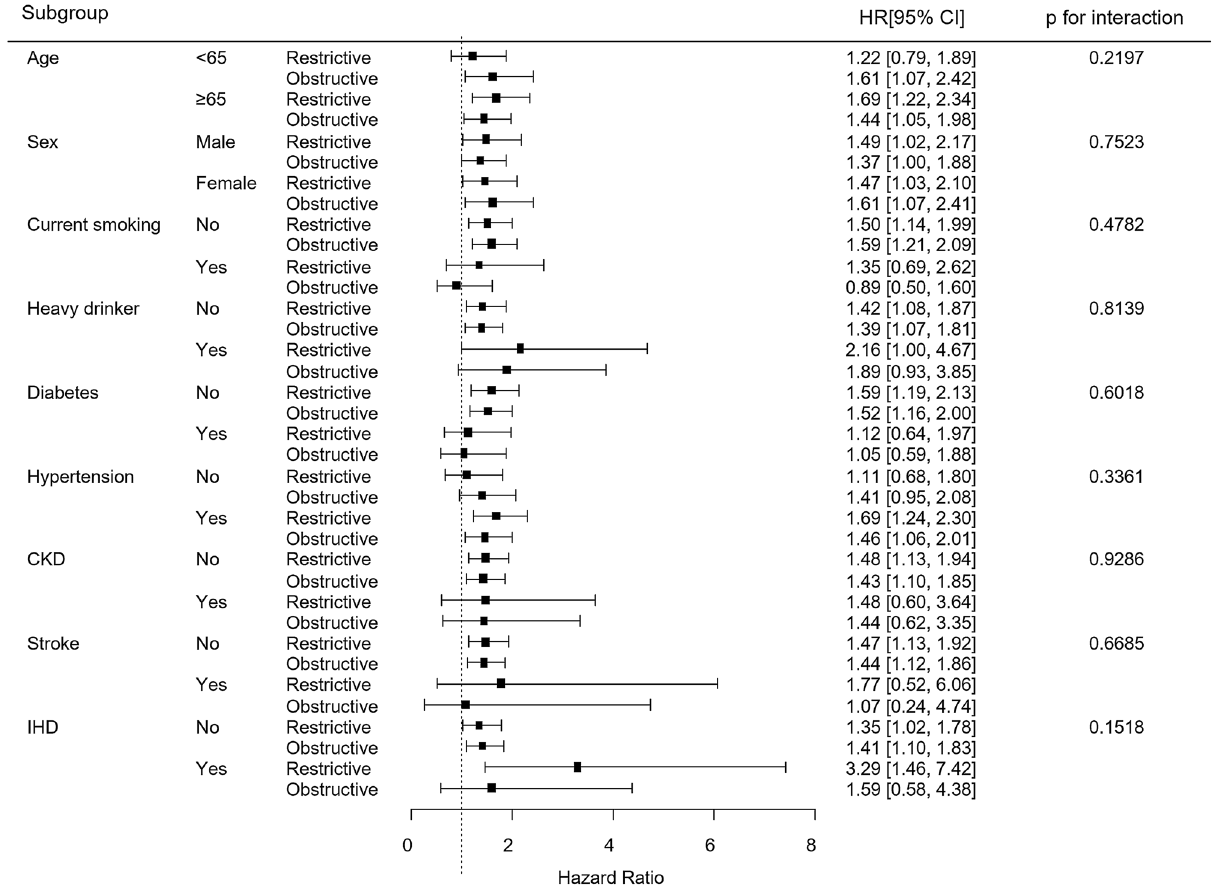
Figure 3. Subgroup analysis for atrial fibrillation risk. All HRs adjusted for covariates including age, sex, BMI, household income, education, exercise, alcohol consumption, smoking, hypertension, DM, dyslipidemia, white blood cell count, eGFR, stroke, IHD, and asthma. CKD chronic kidney disease, IHD ischemic heart